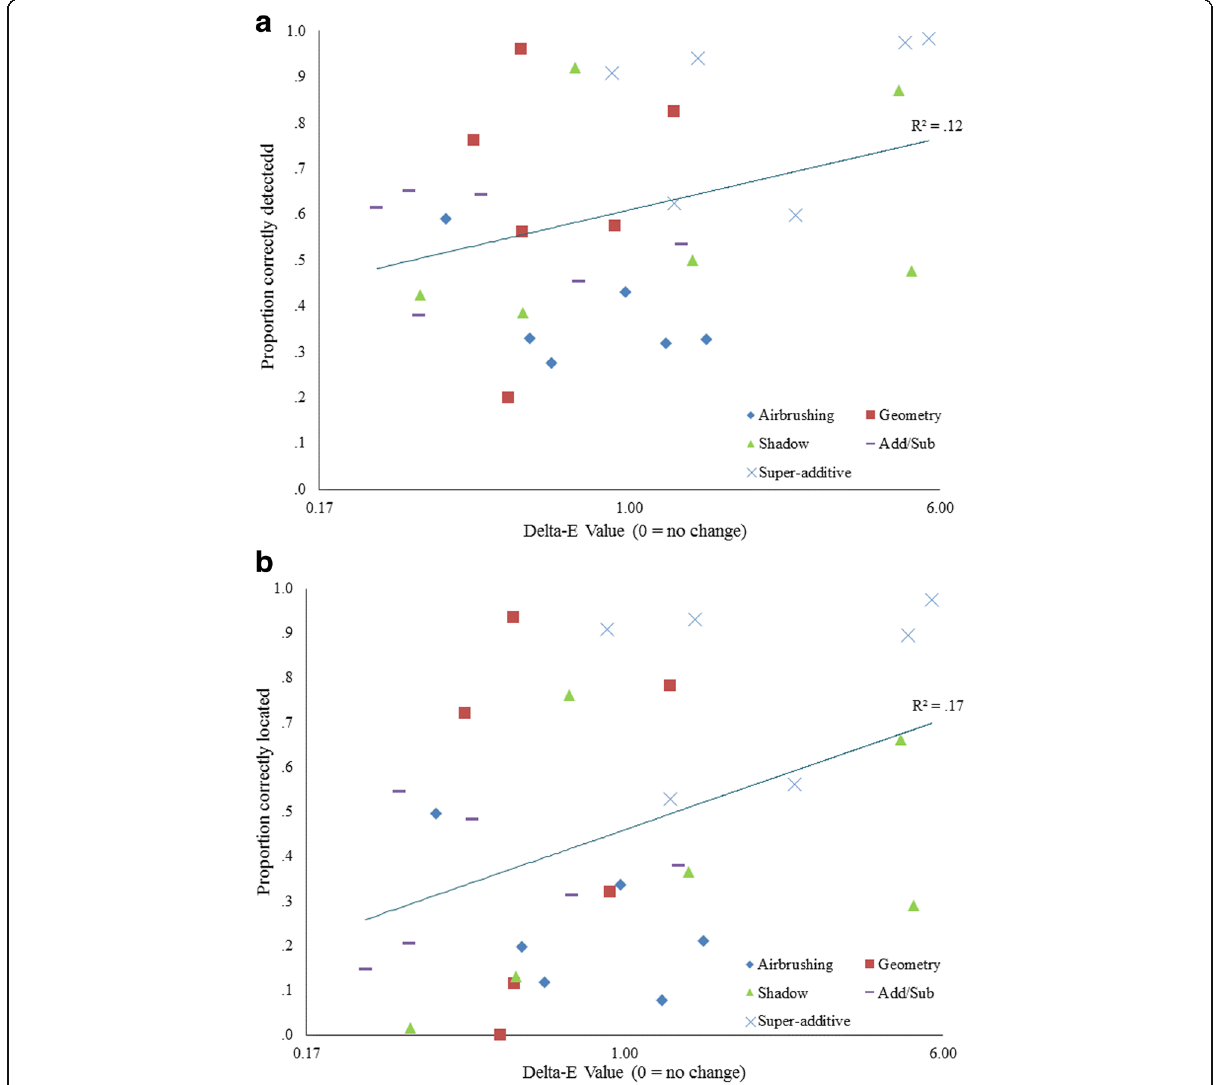
Fig. 5 Mean proportion of correctly detected ( a ) and located ( b ) image manipulations by extent of pixel distortion as measured by Delta-E. The graphs show individual data points for each of the 30 manipulated